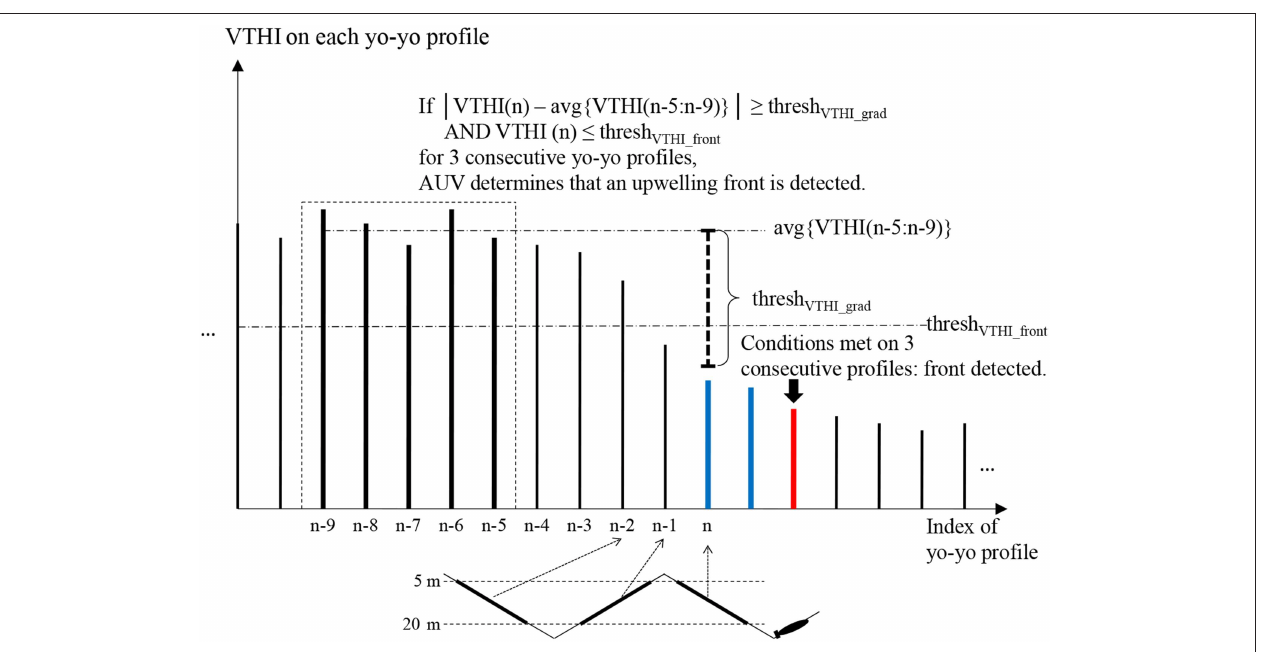
FIGURE 4 | Illustration of the AUV front detection algorithm when flying from stratified water to upwelling water. The first two profiles that satisfy VTHI ≤ thresh VTHI _ front and the horizontal gradient (absolute value) of VTHI ≥ thresh VTHI _ grad are marked blue. The third such profile is marked red where the AUV determines front detection. Adapted from Zhang et al. (2012c) with permission. high horizontal gradients between the upwelling filament and the yo trajectory between the surface and 25-m depth (except for a small portion where the water depth was smaller than 33